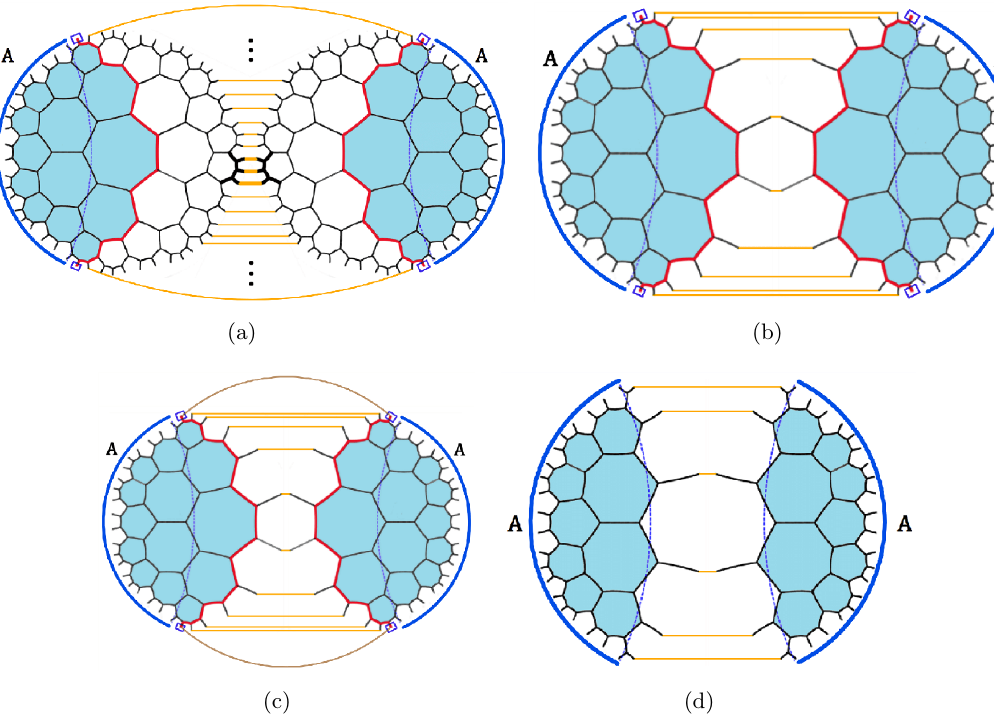
Figure 22 . The evaluation of (cid:26) A . The interval A is marked by solid lines in blue. The geodesic bounded by @A is plotted as a dashed line in blue. The CP tensor chain is marked by a solid line in red, and its two endpoints on the boundary are marked by two blue rectangles. (a) The contractions of indexes in (cid:22) A are illustrated by orange lines. (b) Before the endpoints of CP tensor chain are contracted, CP tensor chains are not absorbed. (c) The contractions of the endpoints of CP tensor chain on the boundary is marked by brown lines. (d) CP tensor chains are absorbed at the (cid:12)nal stage.